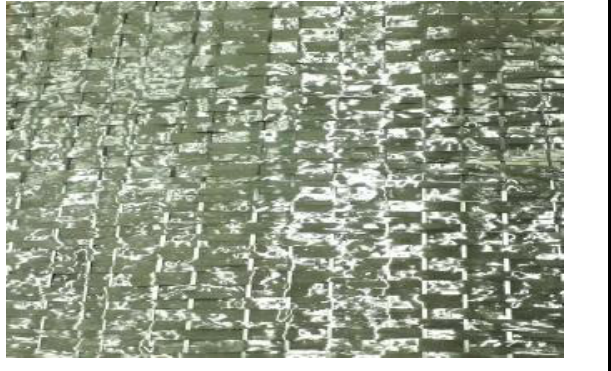
FIGURE 21 KEVLAR PREFORM PLAIN WEAVE (1/1) FIG.19 3D VIEW OF SPRING